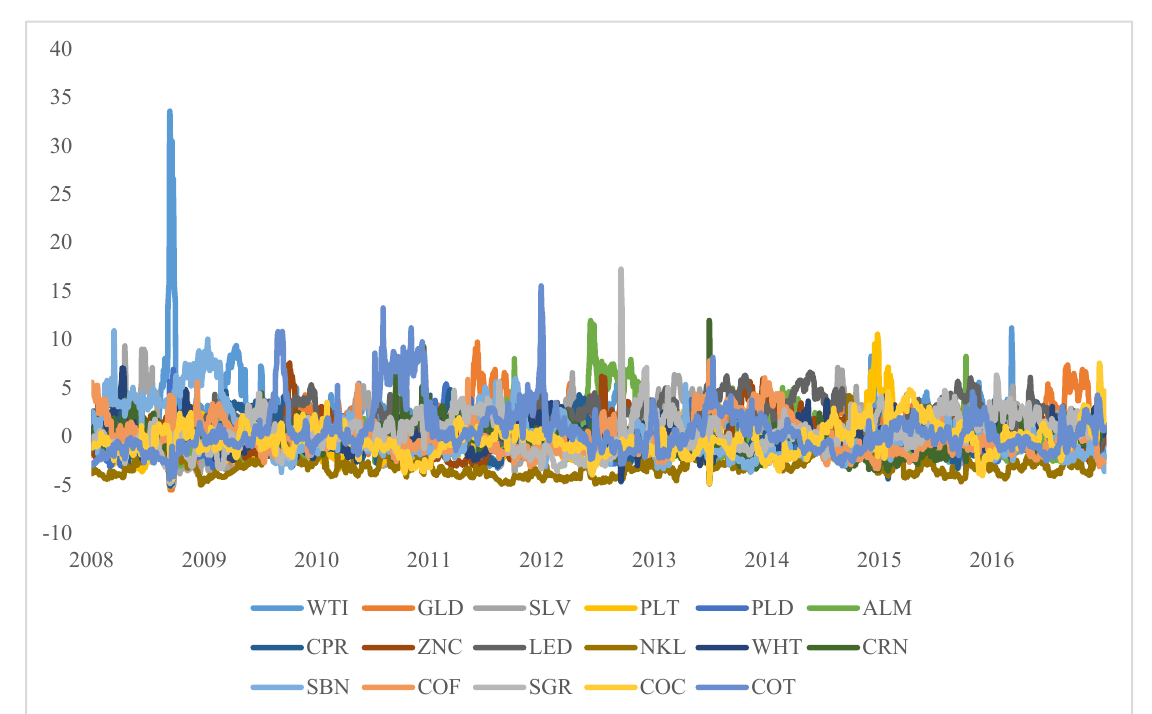
Figure 1. Dynamics of net directional connectedness of oil and other commodity uncertainties.